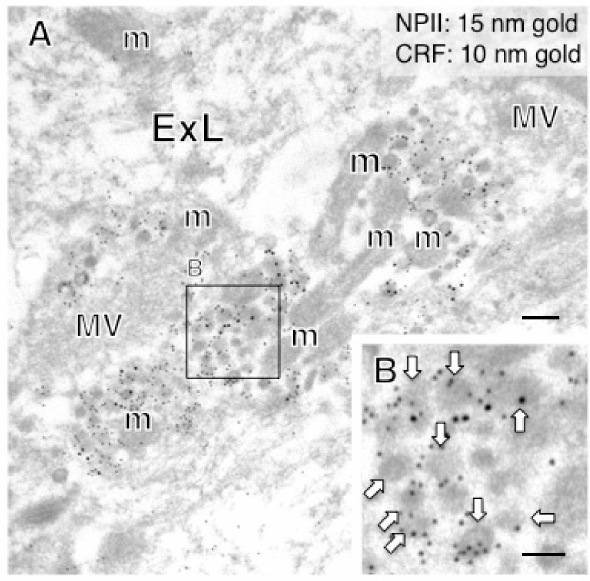
Figure 10. Double-label immunoelectron microscopy for vasopressin-associated neurophysin (NPII) and corticotrophin-releasing factor (CRF) in the external layer (ExL) of the macaque median em- inence. In some axonal varicosities, numerous dense-cored neurosecretory vesicles were doubly immunopositive for CRF (10-nm gold particles) and NPII (15-nm gold particles). The outlined area in ( A ) is enlarged in ( B ). Scale bars, 200 nm, and 100 nm in the enlarged image. Arrows indicate dense-cored neurosecretory vesicles. m, mitochondrion; MV, clustered